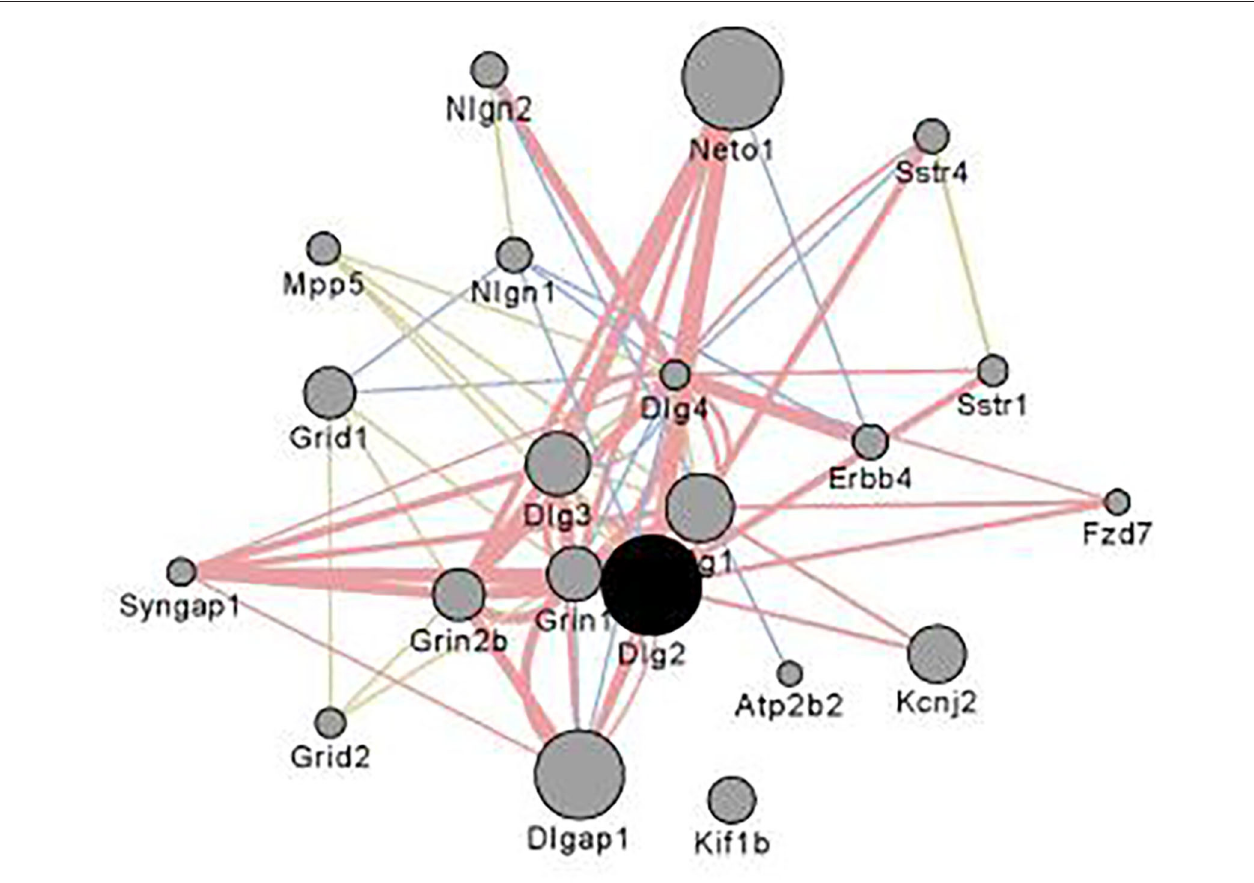
FIGURE 4 | Interaction partners for Dlg2 extracted using Gene Mania (84) which was accessed as a Cytoscape plugin with default settings. Depicted are top 20 genes related to Dlg2 through physical interactions, colocalizations, or sharing protein domains. Dlg2 which encodes for PSD93, interacts with a number of genes and gene products associated with glutamate receptor activity including Dlg4, Syngap1, Neto, Grin1, Grin2b,Dlgap1 & Dlg3 . Figure reprinted with permission from (82).